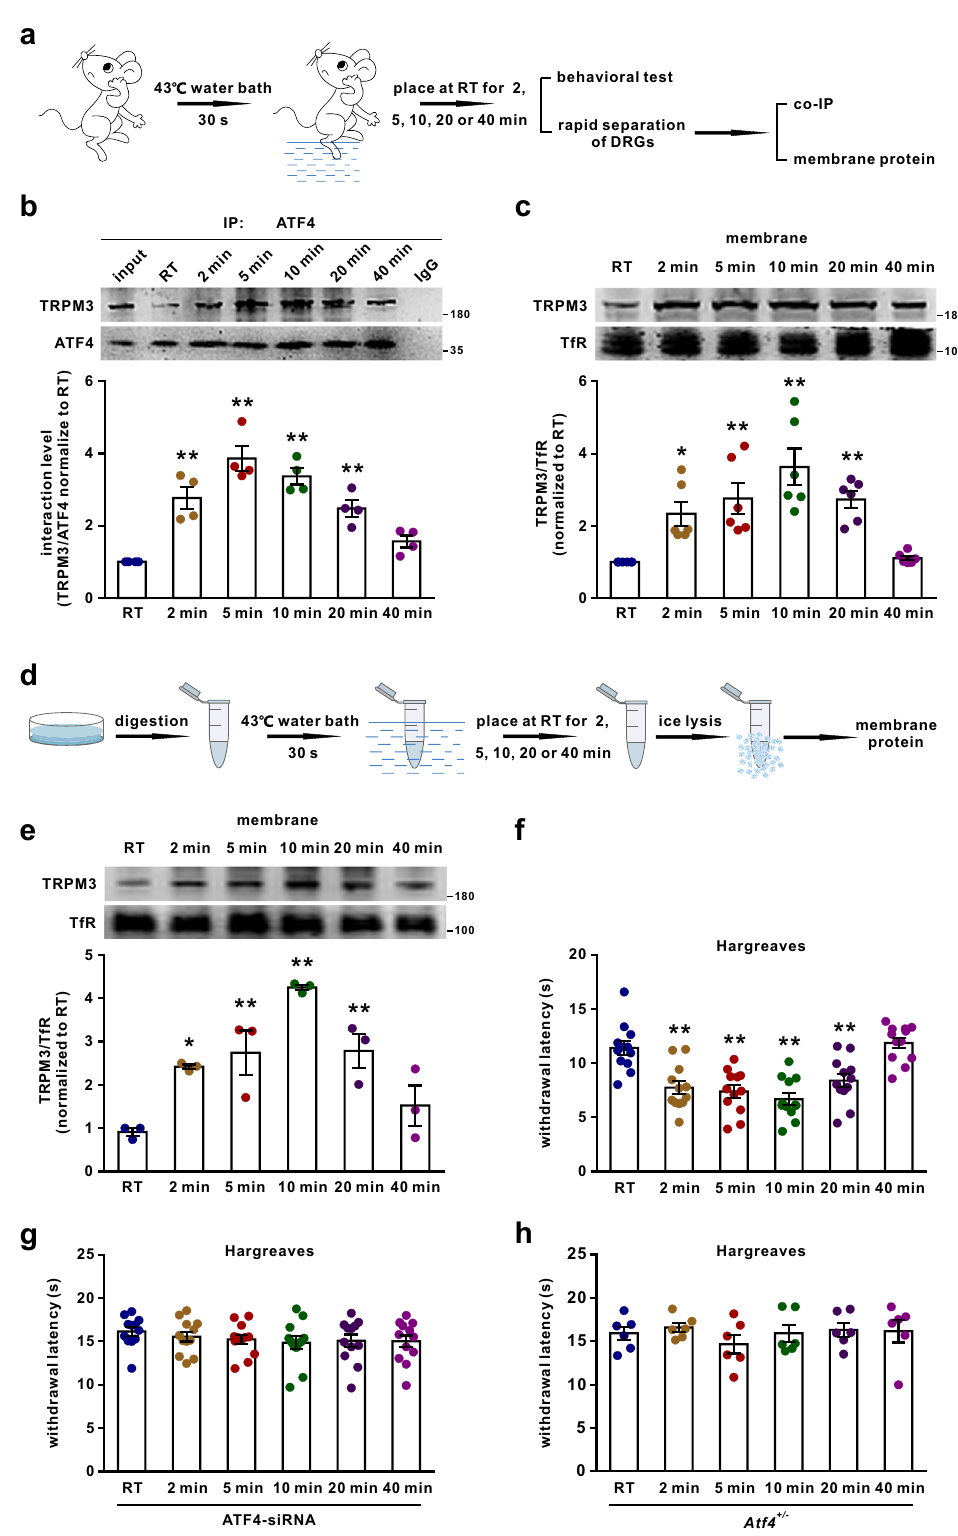
increase in TRPM3 membrane expression induced by ATF4 overexpression was reversed by KIF17 siRNA in DRG neurons. These results suggested that the motor protein KIF17 plays a cri- tical role in ATF4-dependent TRPM3 traf fi cking in DRG neurons. The chemokine CXCL12 plays a critical role in regulating neural activity. For example, in the dorsal raphe nucleus